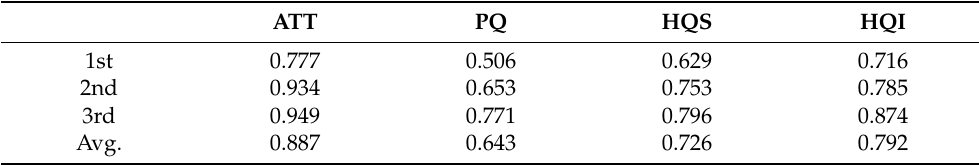
Table 4. Cronbach’s alpha coefficient for AttrakDiff.